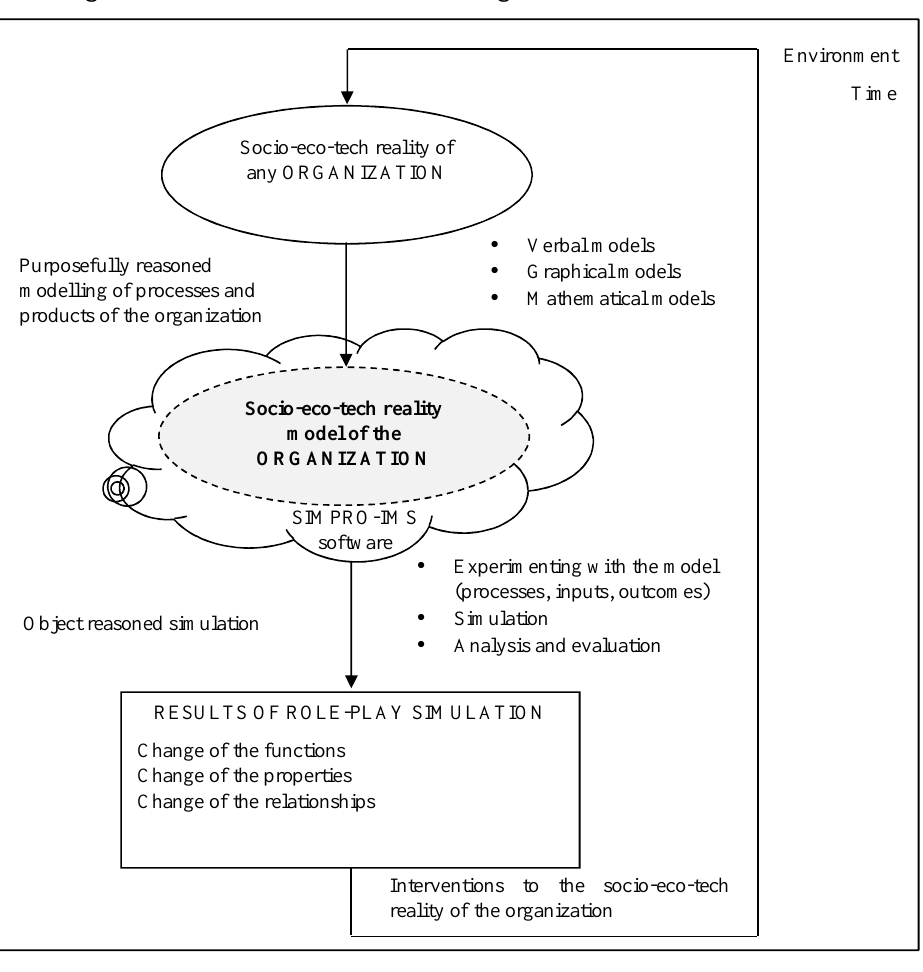
Figure 1 – Position of the SIMPRO-IMS within the frame of the modelling, simulation and correcting of socio-eco-technical reality in an